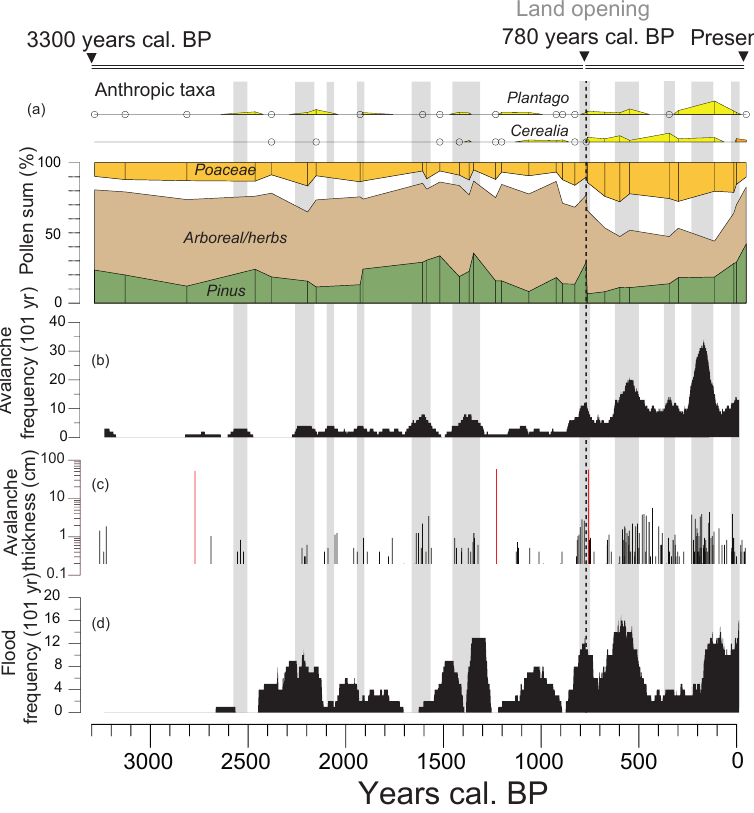
Figure 7. Lake Lauvitel extreme event erosion pattern versus pollen data. (a) Anthropic taxa found in pollen analysis, and pollen sum (%) of Poaceae , Pinus and ratio between arboreal/herb pollen. (b) Lake Lauvitel avalanche chronicle averaged for 101 years. (c) Lake Lauvitel avalanche thickness in centimeters (red bars correspond to the three thickest avalanche deposits). (d) Lake Lauvitel flood chronicle (101-year average). Grey bands indicate periods of higher avalanche